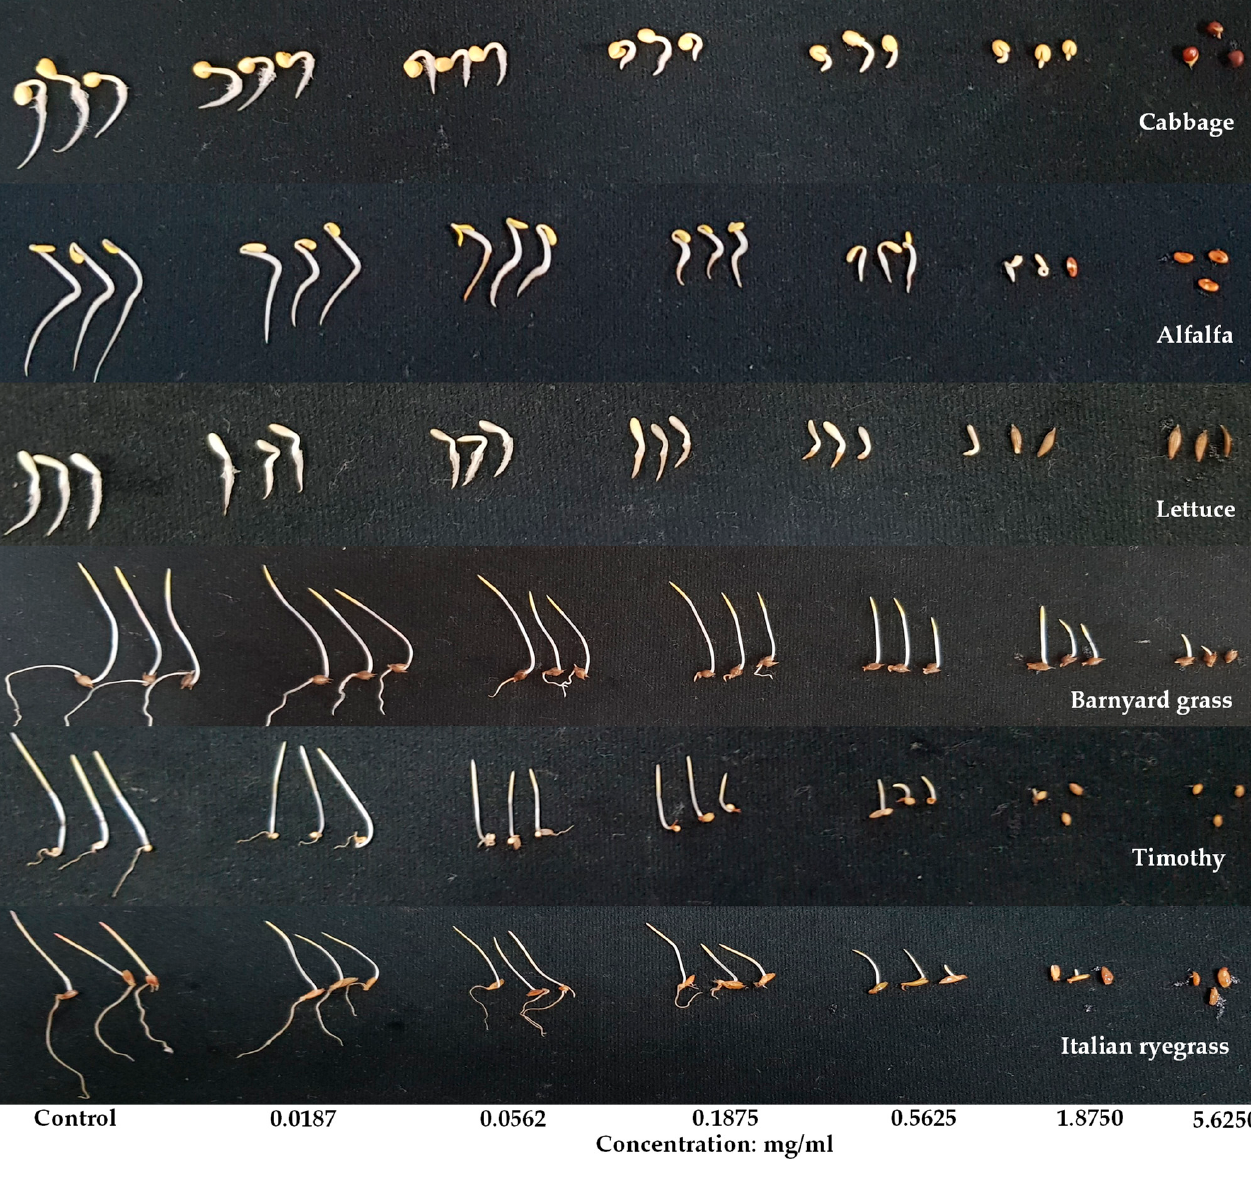
Figure 2. Allelopathic activity of the A. procera leaf extracts against the growth of the test plant spe- cies.